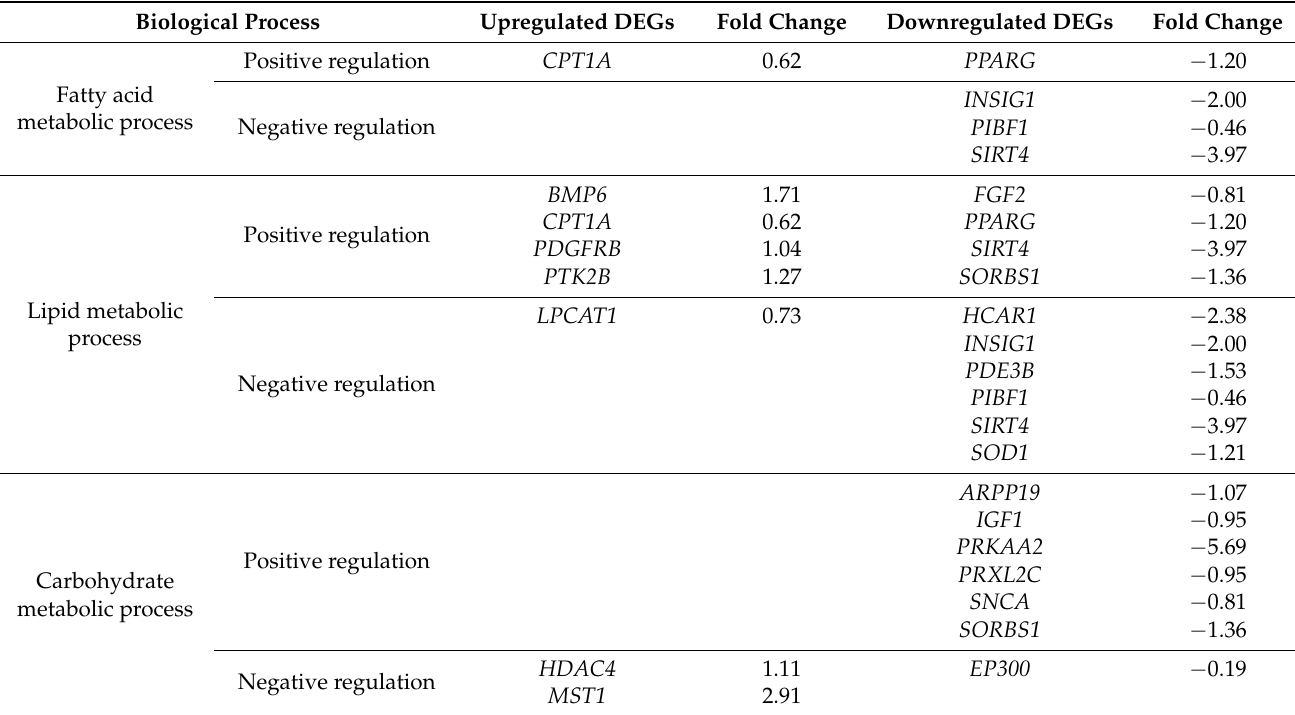
Table 3. Differentially expressed genes (DEGs) up and downregulated involved in the “Regula- tion of fatty acid metabolic process”, “Regulation of lipid metabolic process” and “Regulation of carbohydrate metabolic